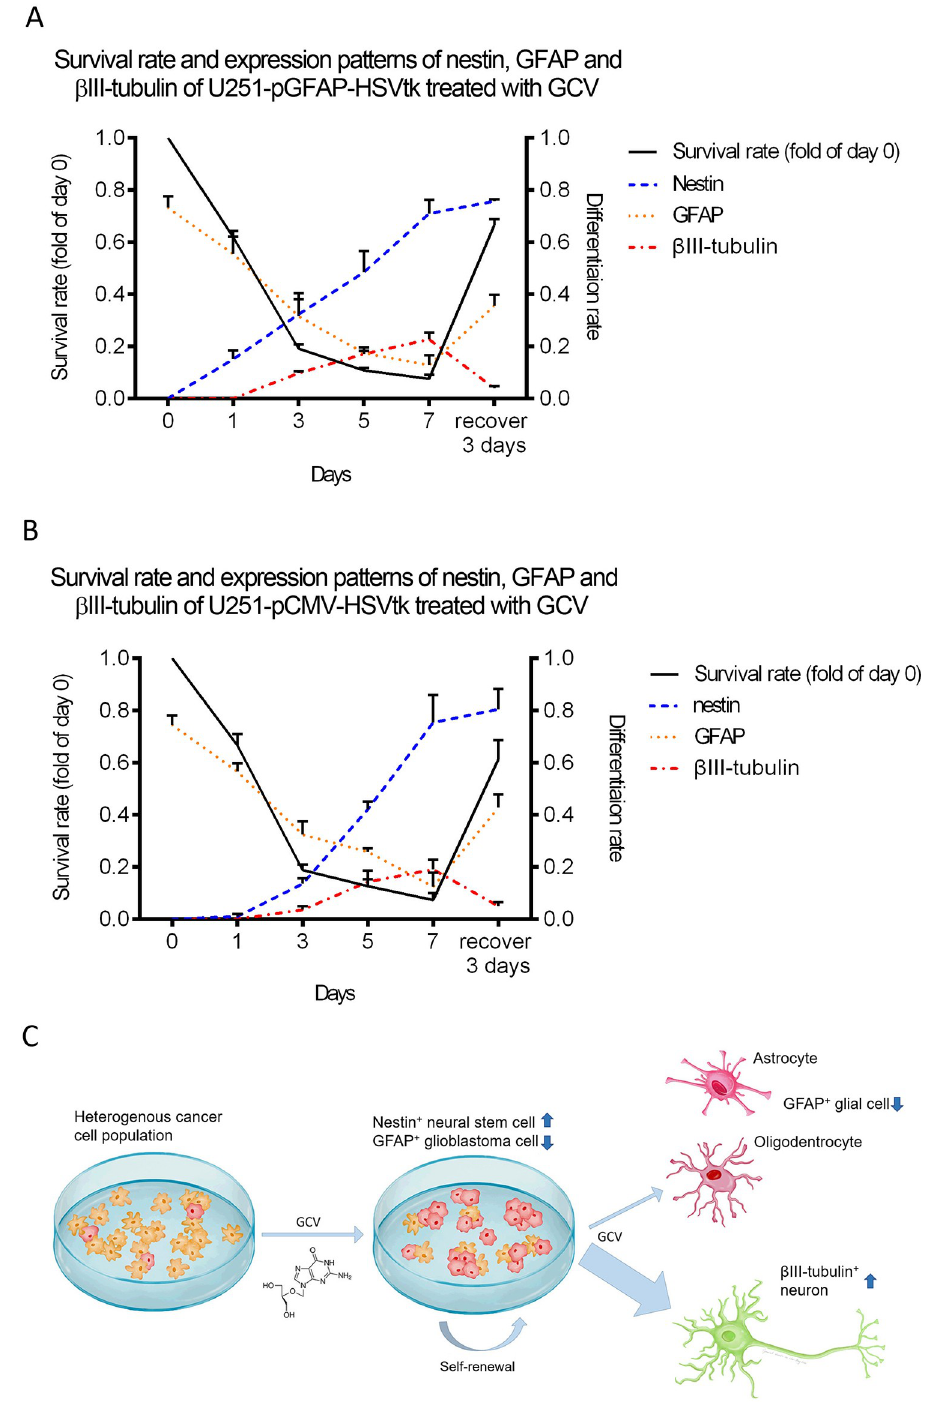
Fig 6. Summary of the main results in this study. The survival rate and expression ratio of nestin, GFAP, and β III- tubulin in U251-pGFAP-HSVtk (A) and U251-pCMV-HSVtk (B) cells were determined by quantifying confocal images of immunocytochemistry (n = 3). The survival rate of both stable clones was decreased when cells were treated with GCV, but increased after recovery. The ratio of nestin-positive cells in both clones increased during GCV treatment and even after recovery. The ratio of GFAP-positive cells in both clones decreased during GCV treatment and increased after recovery. The ratio of β III-tubulin-positive cells in both clones increased during GCV treatment and decreased after recovery. (C) The HSVtk/GCV system driven by the GFAP promotor could successfully ablate GFAP-positive glioblastoma cells while leaving non-glial cells intact. In addition, neural differentiation was promoted after challenge with this HSVtk/GCV